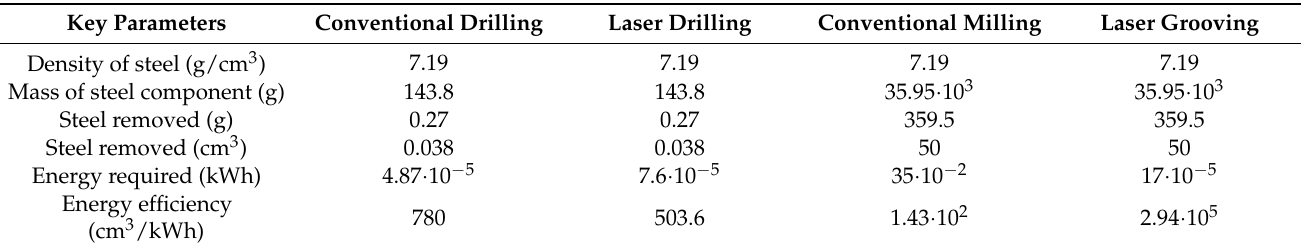
Table 6. Key parameters of processes that were used for the calculation of the environmental impact and carbon footprint.